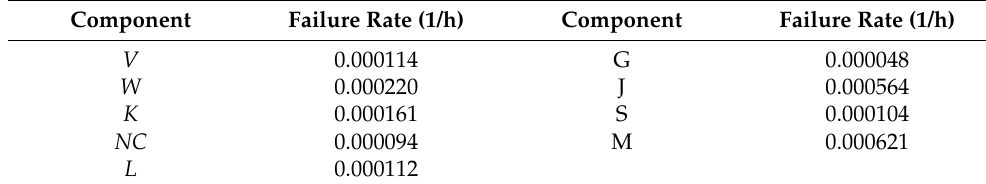
Table 5. Failure rate of each component of the machining center at 4000 h.